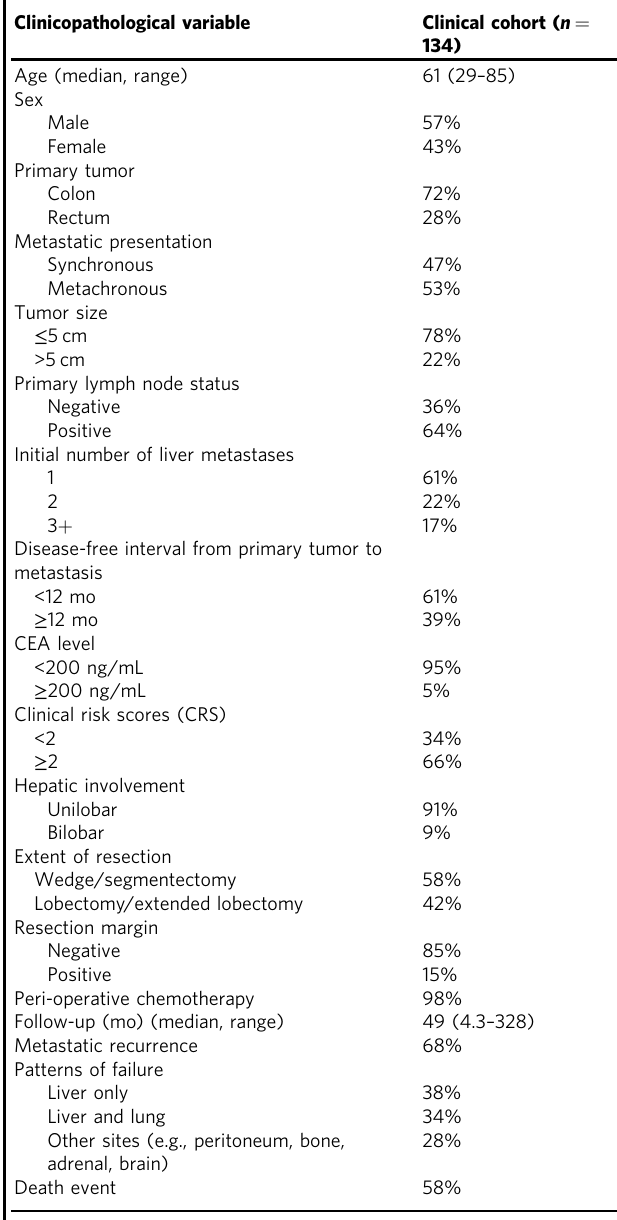
Table 1 Clinical and pathological characteristics of colorectal cancer